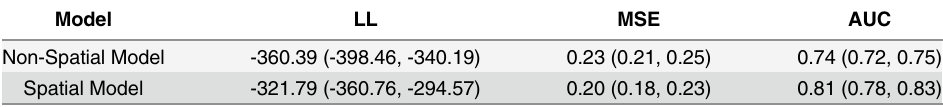
Table 2. Posterior mean (95% Credible Intervals) for LL, MSE and AUC under the Spatial and Non-Spa- tial